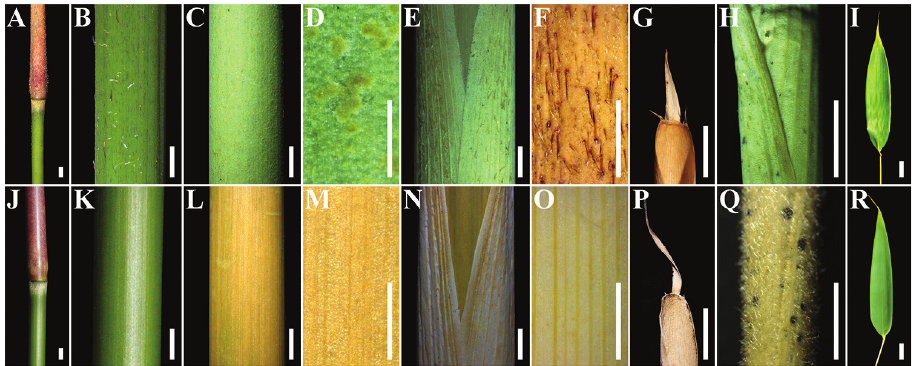
Figure 1. Comparison of morphological characters between plants from Xunwu ( A–I ) and Gelidocala- mus stellatus ( J–R ). A–D, J–M culm and node E–G, N–P culm leaf sheath H, Q branch sheath I, R foli- age leaf. Scale bars: 3 mm ( A–C, E, J–L, N ), 1 mm ( D, F–H, M, O–Q ), 2 cm ( I, R